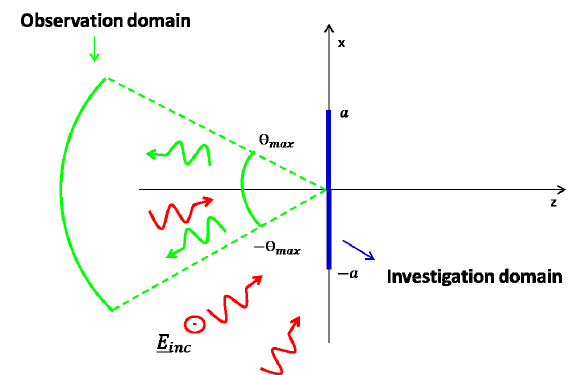
Figure 1: A pictorial view of the scattering configuration considered in this paper is sketched.